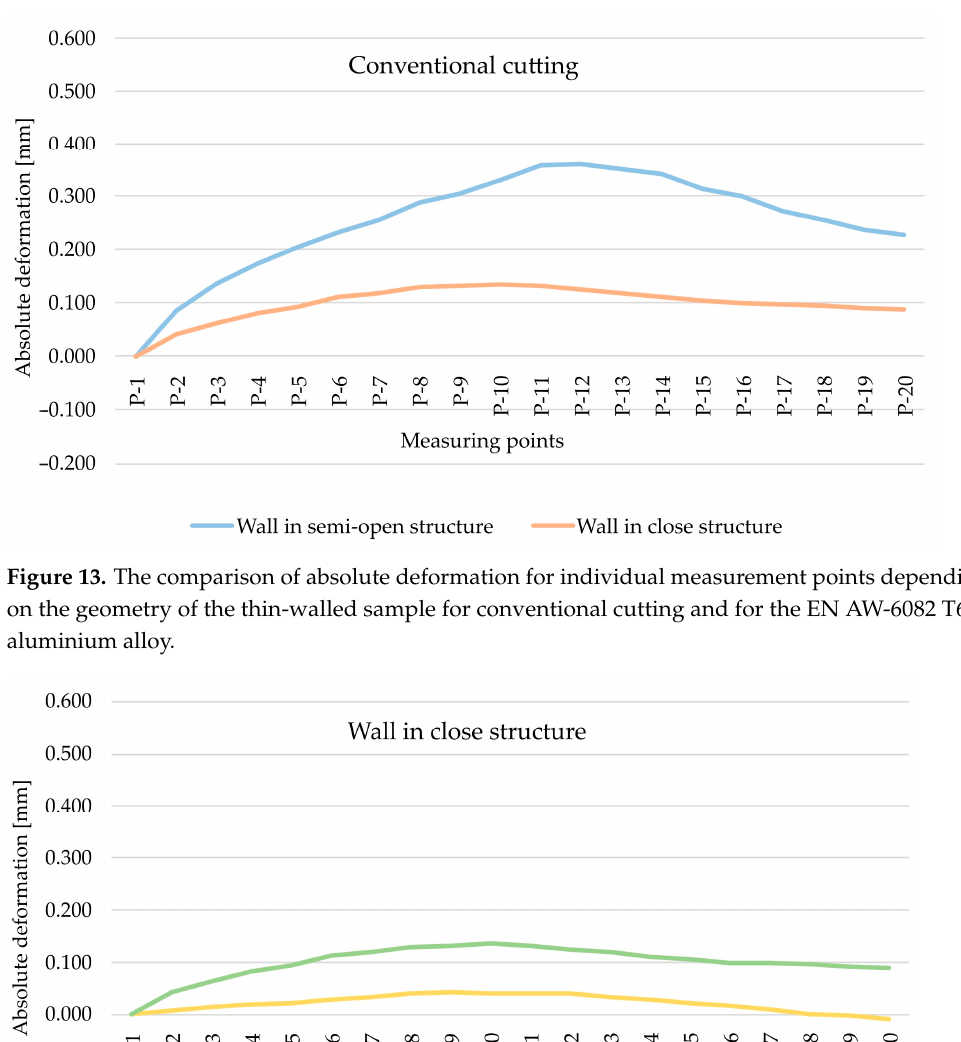
Figure 13. The comparison of absolute deformation for individual measurement points depending on the geometry of the thin-walled sample for conventional cutting and for the EN AW-6082 T651 aluminium alloy.